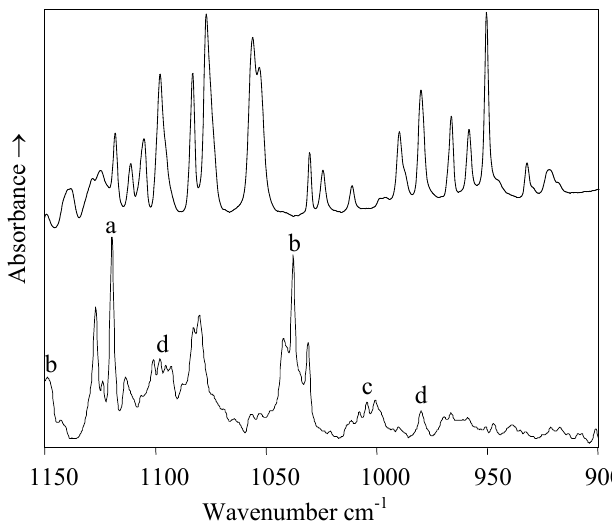
Fig. 4. IR absorption spectrum of 1-butene SOZ isolated in N 2 Figure 4. IR absorption spectrum of 1-butene SOZ isolated in N matrix at 10 K (top) before photolysis and after photolysis (bottom). 2 a - formic acid, b- propionic acid, c- propanal, d - formaldehyde. matrix at 10 K (top) before photolysis and after photolysis (bottom). a - formic acid, b- propionic acid, c- propanal, d - formaldehyde.